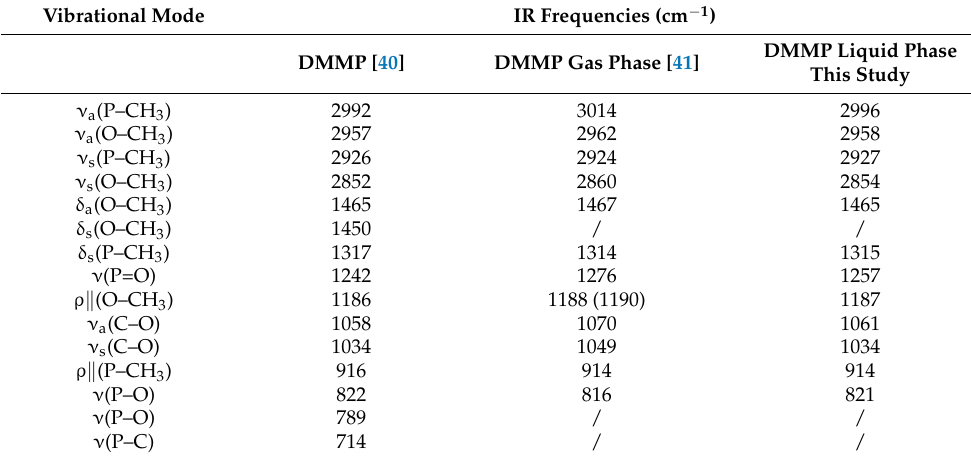
Table 8. IR frequencies and assignments of DMMP.